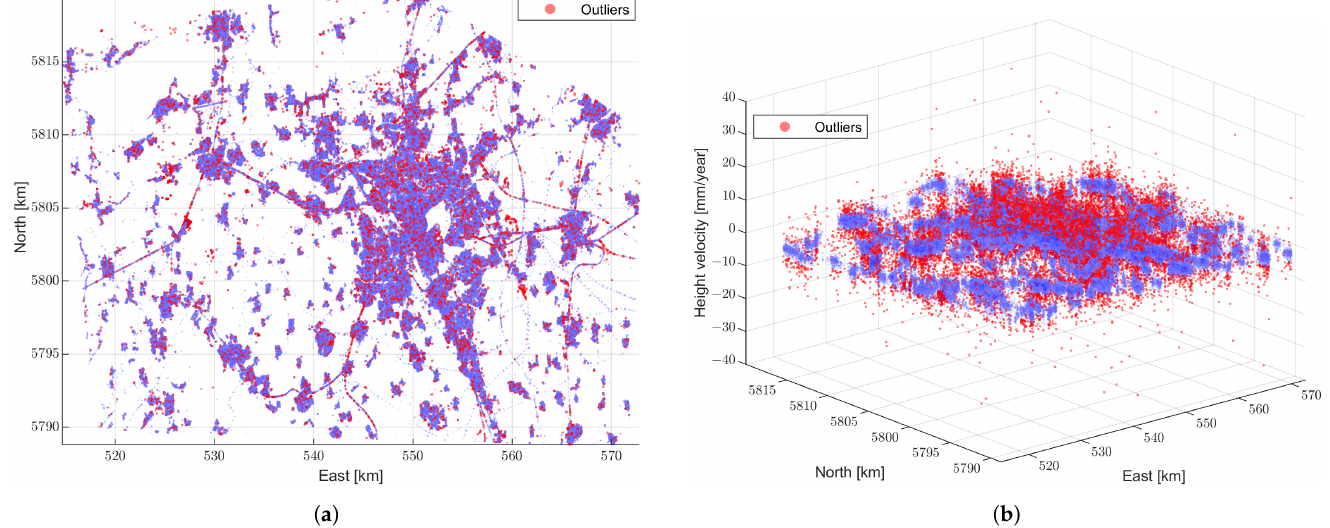
Figure 7. Detected outliers (red points) and the clean observations (blue points). ( a ) 2D view. ( b ) 3D view. Table 3. Comparison of the proposed algorithm with the results from